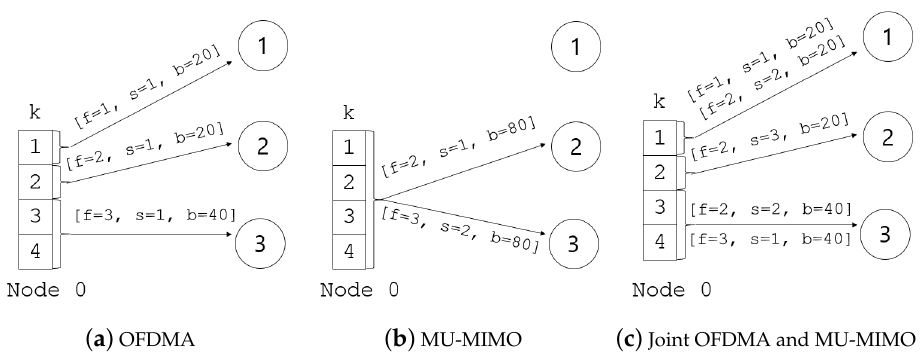
Figure 1. Comparison of OFDMA, MU-MIMO, and joint OFDMA and MU-MIMO operation, where f , s and b represent the index of the flow, the number of spatial streams and the bandwidth,